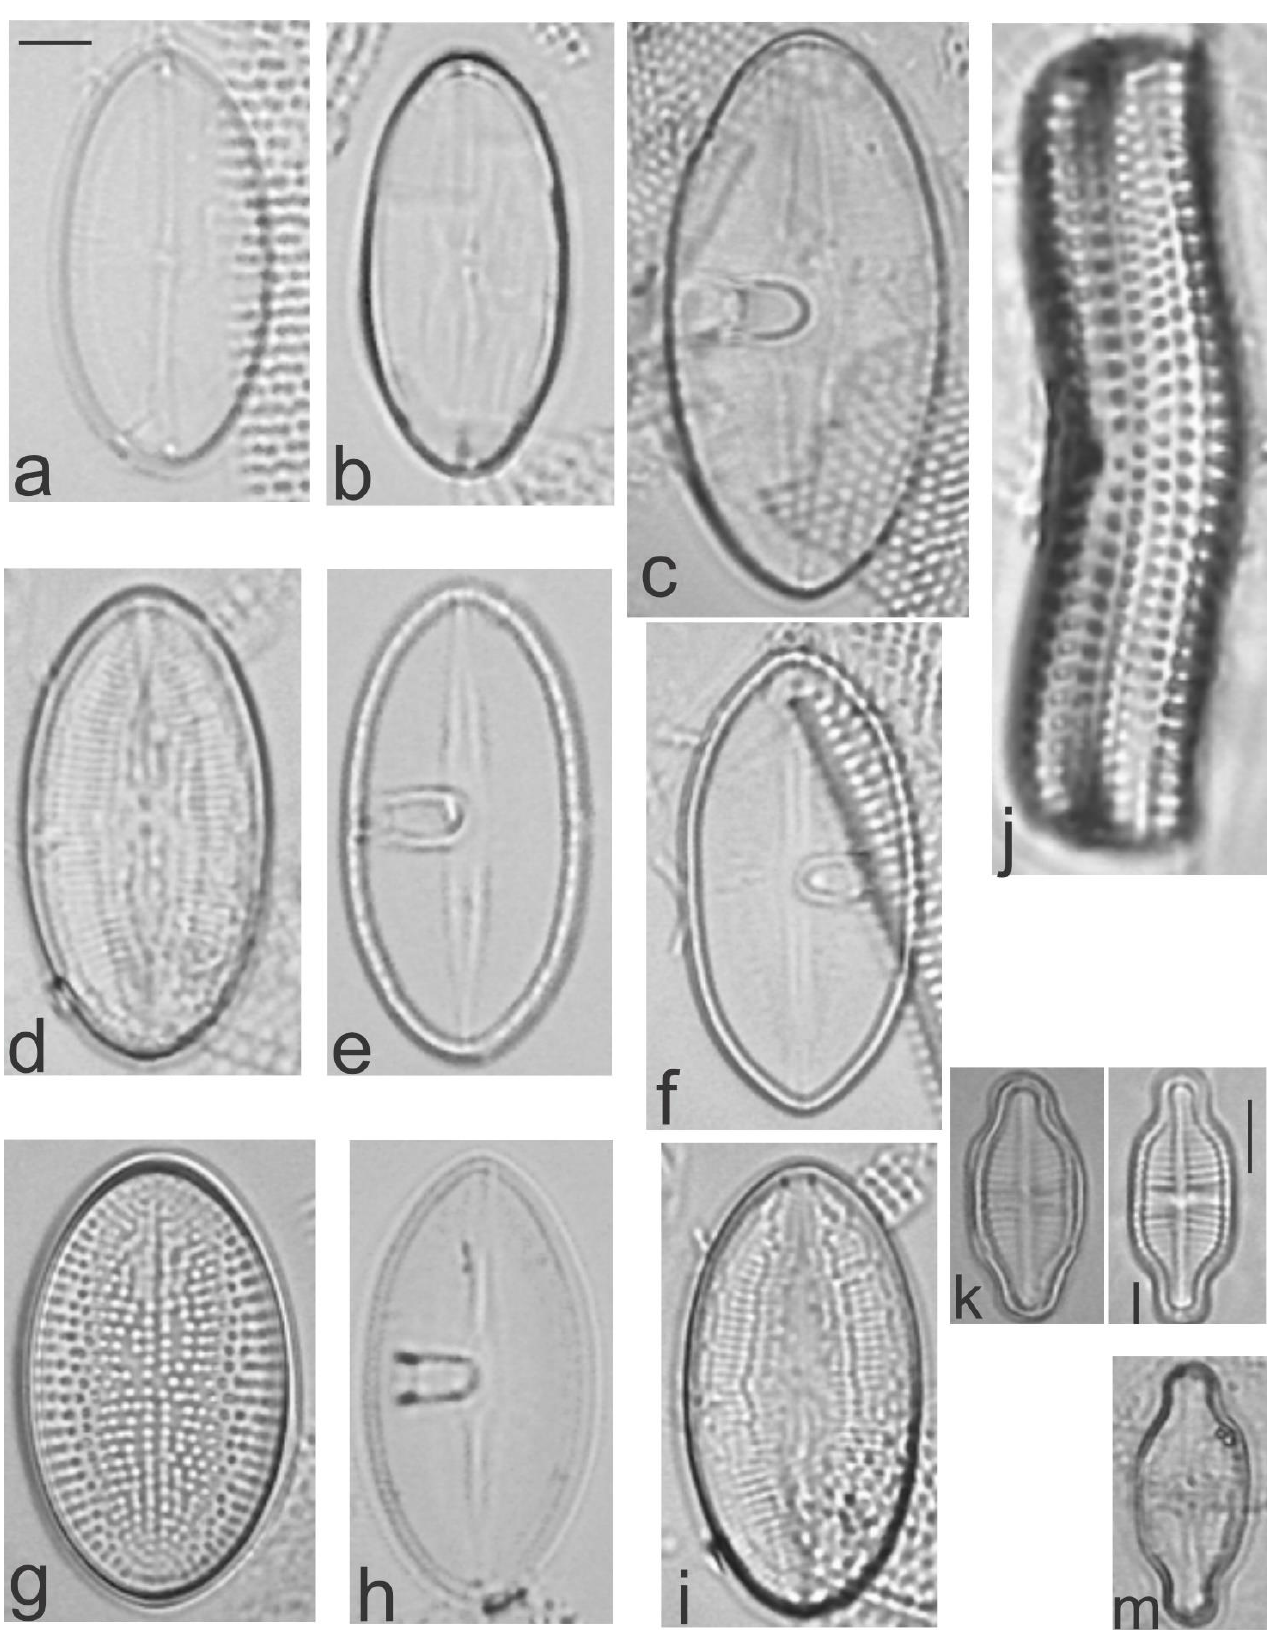
Figure 16. ( a , b ) Achnanthes sp. 2; ( c – f , h , i ) Planothidium sp. 1; ( k – m ) Achnanthidium exiguum var. heterovalvata ; ( g ) Cocconeis hoffmannii ; ( j ) Achnanthes pseudogroenlandica . Scale bar = 5 μm.